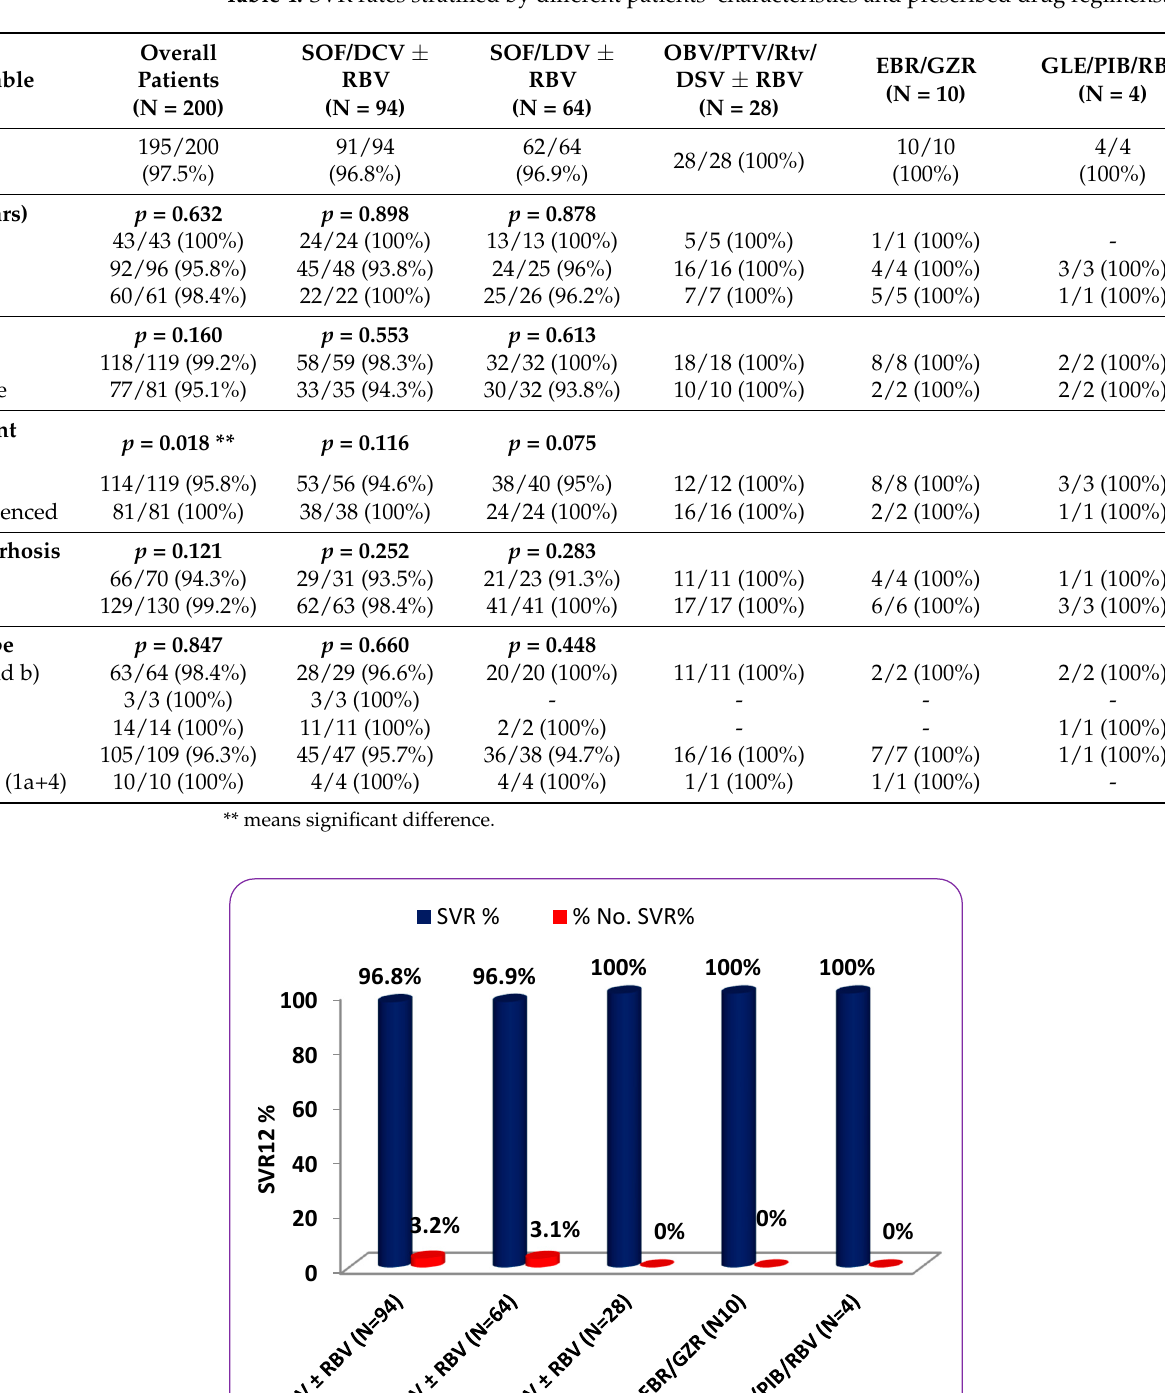
Table 4. SVR rates stratified by different patients’ characteristics and prescribed drug regimens.